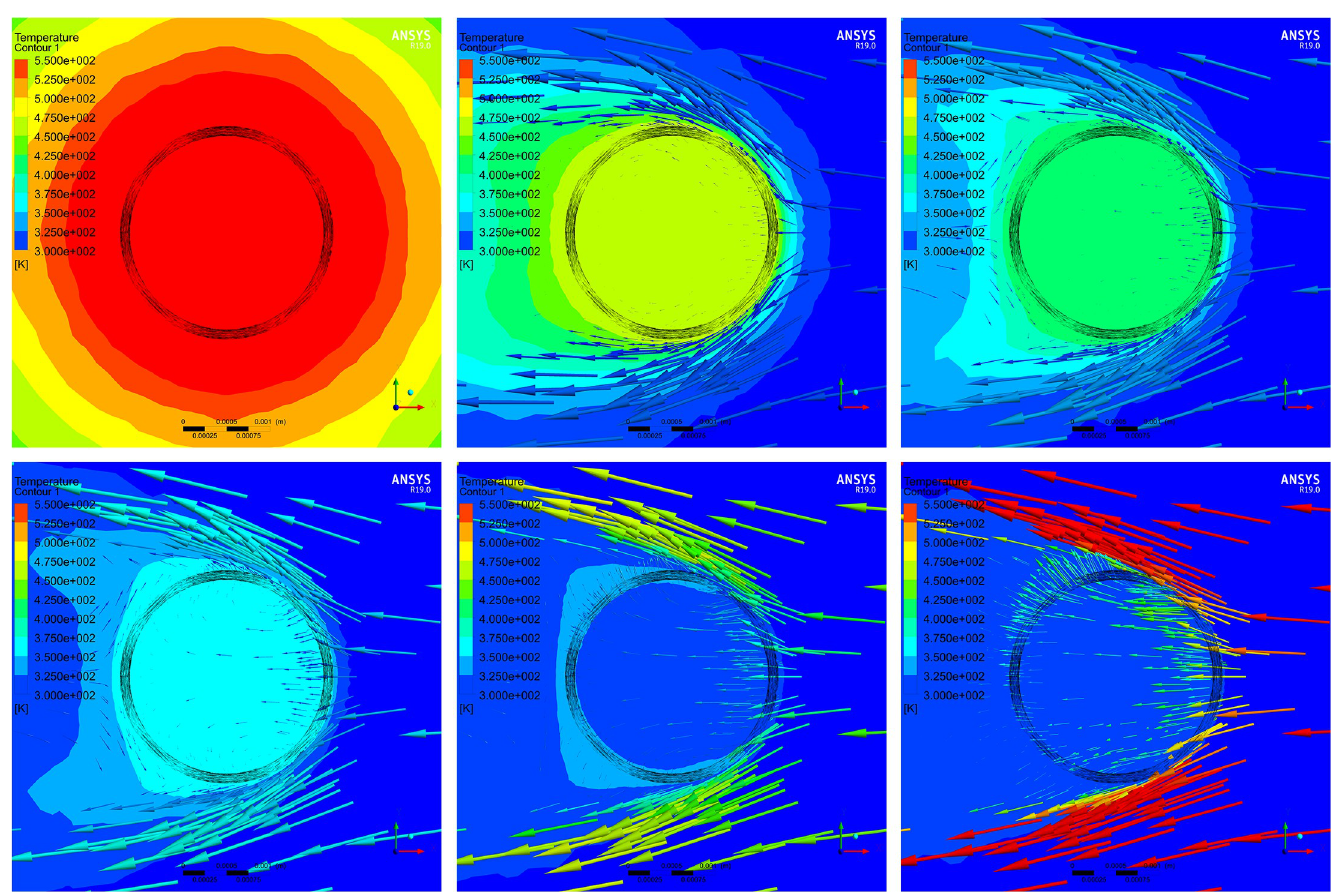
Fig 1. Heat distribution inside the coil working in CP mode under different wind velocities. Results for wind velocities of (A) 0 m/s, (B) 5 m/s, (C) 10 m/s, (D) 20 m/s, (E) 30 m/s, and (F) 40 m/s. https://doi.org/10.1371/journal.pone.0254256.g001 Table 1 summarizes the correspondence between the temperature and wind velocity in the center of the coil in CP mode, as obtained from the simulations. The heat distribution inside the coil is uniform under any wind velocity. In the case of zero wind velocity, the temperature in the center of the coil is approximately 281˚C. When the wind velocity changes, the temperature decreases rapidly and non-linearly. At 20 m/s, the tem- perature is approximately 86˚C. At 20–40 m/s, the temperature does not change significantly, and the lowest temperature is 45.9˚C, which is close to the ambient temperature and can hardly reflect the airflow velocity. Table 1. Wind velocity and temperature of the center of the coil in CP mode. Wind Velocity m/s